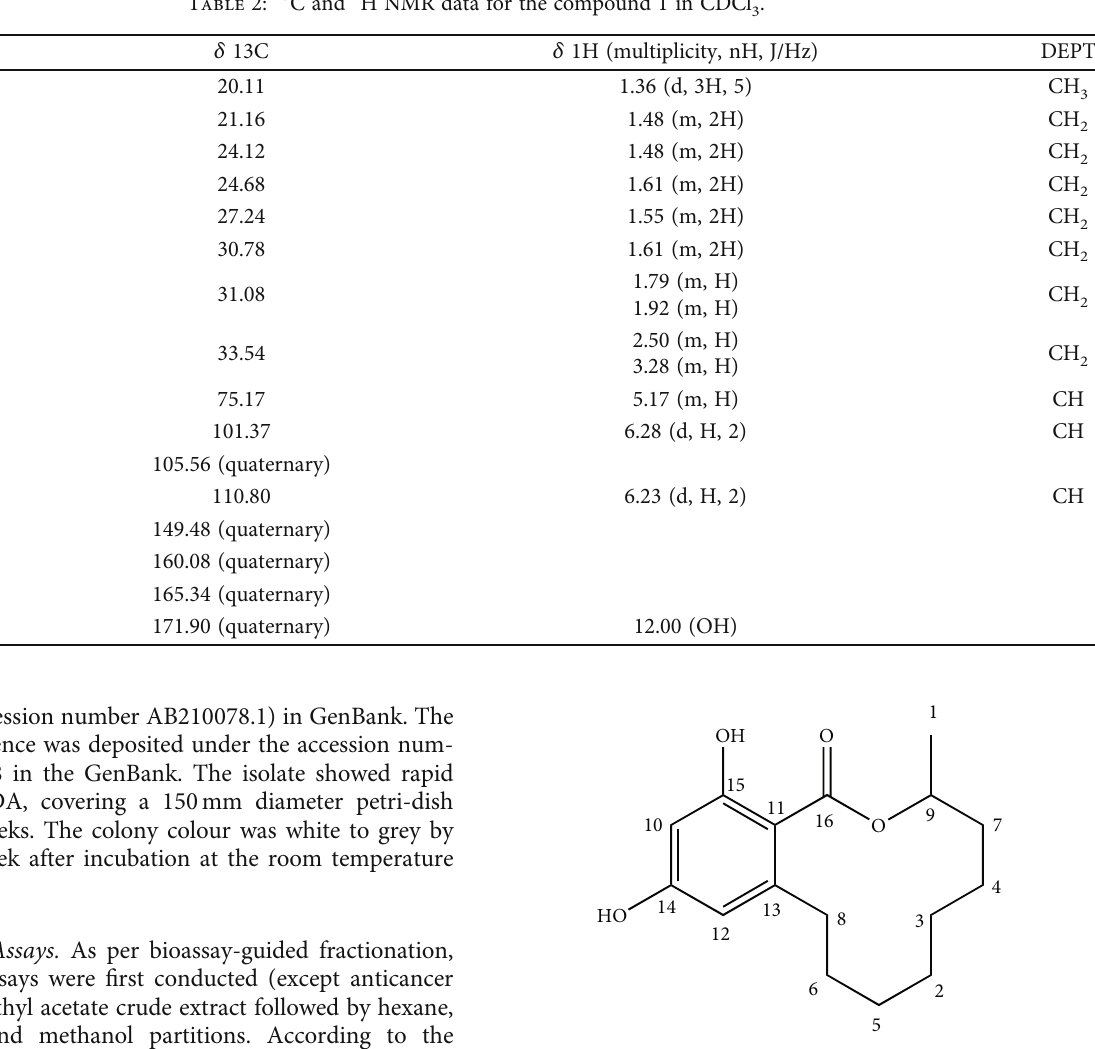
Figure 2: The structure of the compound